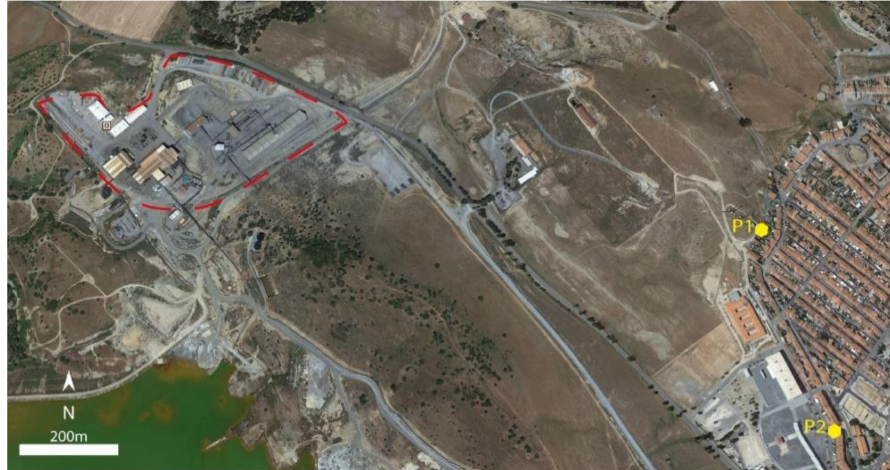
Figure 2. Localization of the ore processing plant of the Aljustrel mine (red line) and the sampling points: P1 and P2 at a distance of 1.2 km and 1.44 km, respectively (source: Google